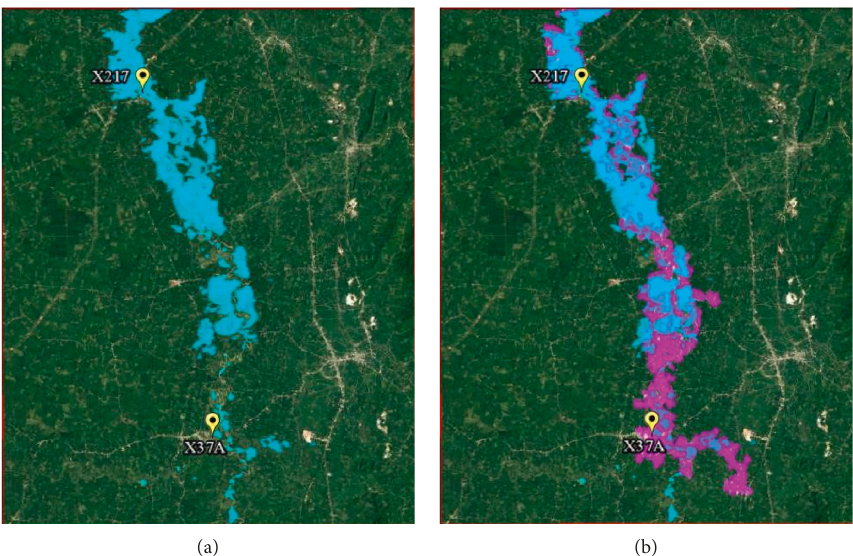
F IGURE 21: The result on January 13, 2017, for the case simulation for 5 consecutive days. (a) The real data from satellite image on January 13, 2017. (b) The difference between real data and the simulation